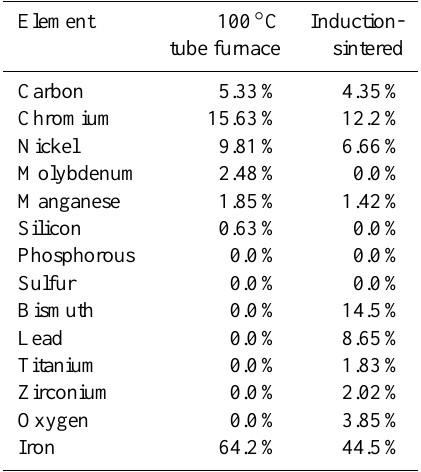
Table 2. Experimental weight percent composition of stainless steel 316L after transducer